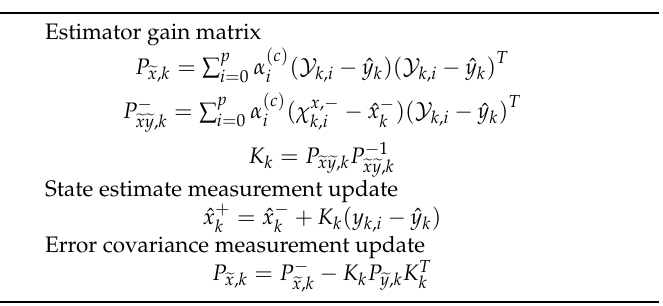
Estimator gain matrix